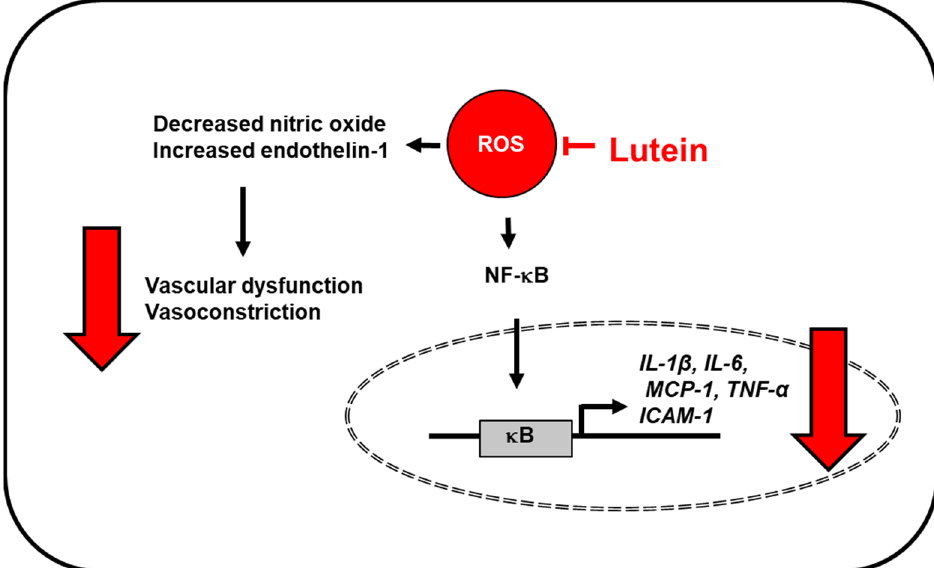
Figure 4. The proposed mechanism by which lutein inhibits oxidative stress-induced inflammatory responses in vascular endothelial cells. ROS levels increase in vascular endothelial cells exposed to high concentrations of homocysteine (atherosclerosis model) or lipopolysaccharide. Lutein reduces ROS levels and inhibits ROS-associated activation of NF-kB and expression of inflammatory mediators (IL-1 β , IL-6, MCP-1, TNF- α , ICAM-1) in endothelial cells [71,76]. Moreover, lutein inhibits ROS-induced vascular dysfunction (decreased nitric oxide and increased endothelin-1), and thus, prevents vasoconstriction [71]. ICAM-1, intercellular adhesion molecule 1; IL, interleukin; MCP-1; monocyte chemoattratant protein-1; NF − κ B, nuclear factor- κ B; ROS, reactive oxygen species; TNF- α , tumor necrosis factor- α .